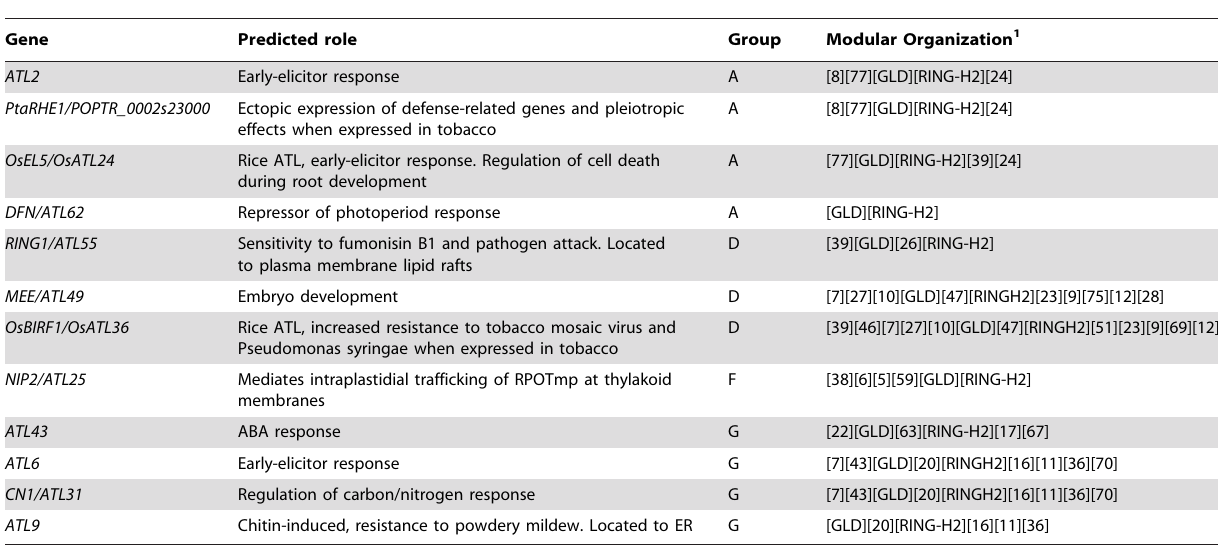
1 A schematic representation of the modular organization can be found in Figure S1.